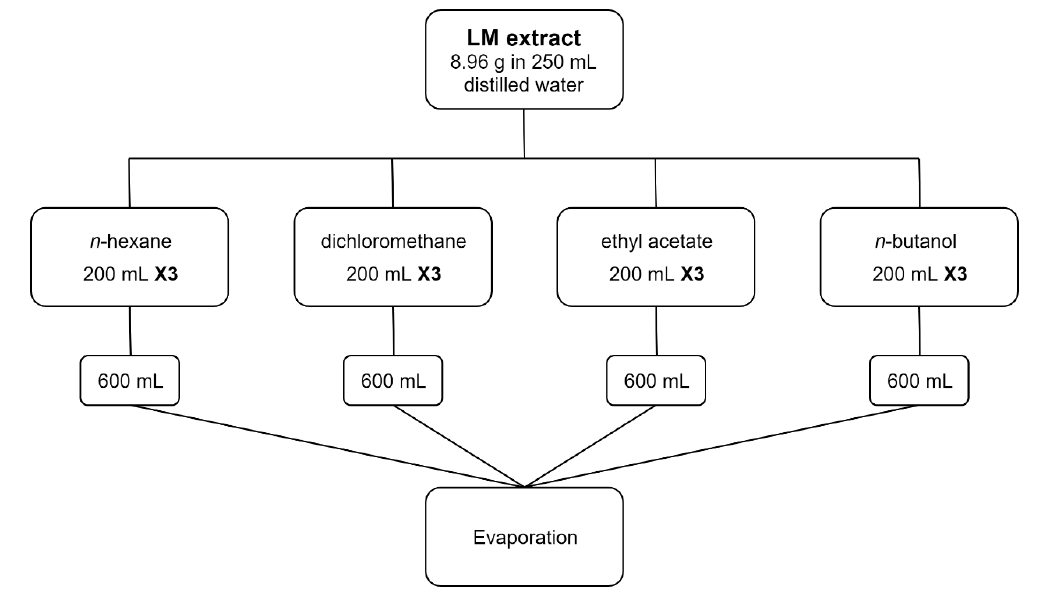
Figure 1. Fractionation diagram of leaves macerate extract.